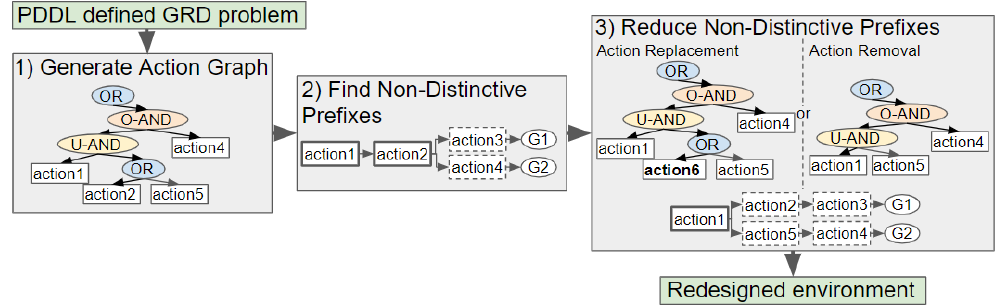
Figure 2. Conceptual overview of our novel approach to goal recognition design (GRD). An Action Graph is created from a GRD problem defined in PDDL. This Action Graph is traversed to identify non-distinctive prefixes. In the third step, modifications are performed to reduce the non-distinctive prefixes, leading to a redesigned environment with an increased goal